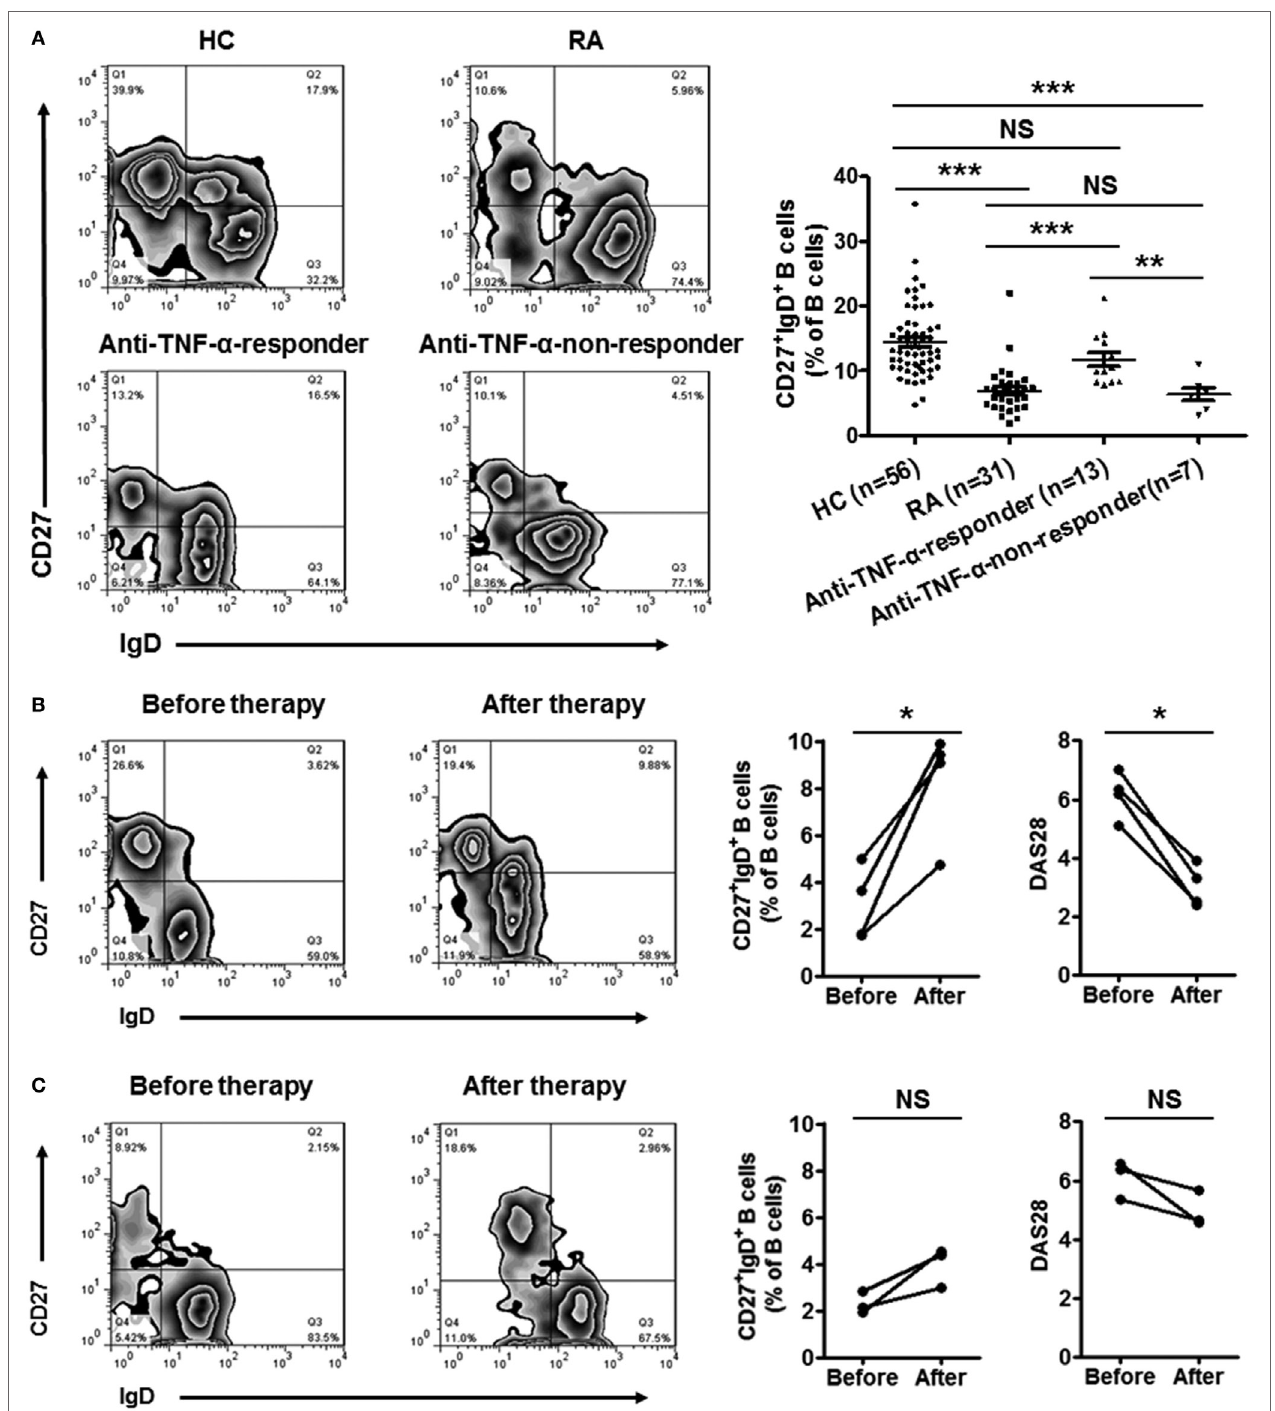
FigUre 6 | Recovery of CD27 + IgD + B cells in rheumatoid arthritis (RA) patients with disease remission after therapy. (a) The frequencies of CD27 + IgD + B cells in RA patients receiving anti-TNF- α mAb therapy ( n = 20, 13 responders and 7 non-responders) or not ( n = 31) were analyzed by flow cytometry. The representative flow charts and the statistical results were shown (one-way ANOVA, ** P < 0.01, *** P < 0.001, NS, not significant). (B,c) Seven RA patients (DAS28 > 5.1) before and after anti-TNF- α antibody treatment were recruited in the study. The frequencies of CD27 + IgD + B cells as well as the disease activity score DAS28 were analyzed (Paired t -test, * P < 0.05, NS, not significant). (B) 4 good responders, (c) 3 poor